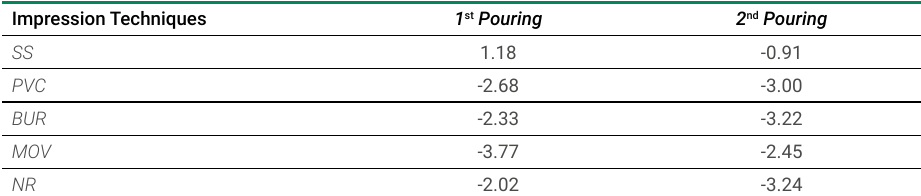
Table 2. Mean area (mm 2 ) from the differences between Baseline and casts’ values for each Impression Technique and Pouring . Impression Techniques